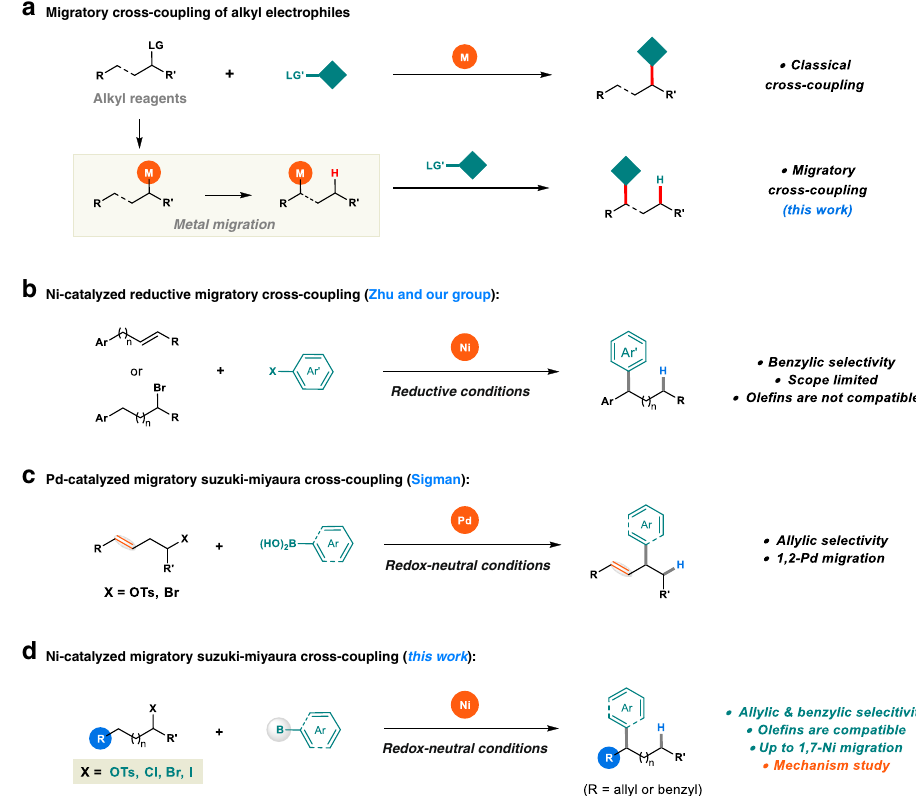
Fig. 1 Transition metal-catalyzed migratory cross-coupling. a Migratory cross-coupling of alkyl electrophiles. b Ni-catalyzed reductive migratory cross- coupling. c Pd-catalyzed migratory Suzuki – Miyaura cross-coupling. d The approach developed in this